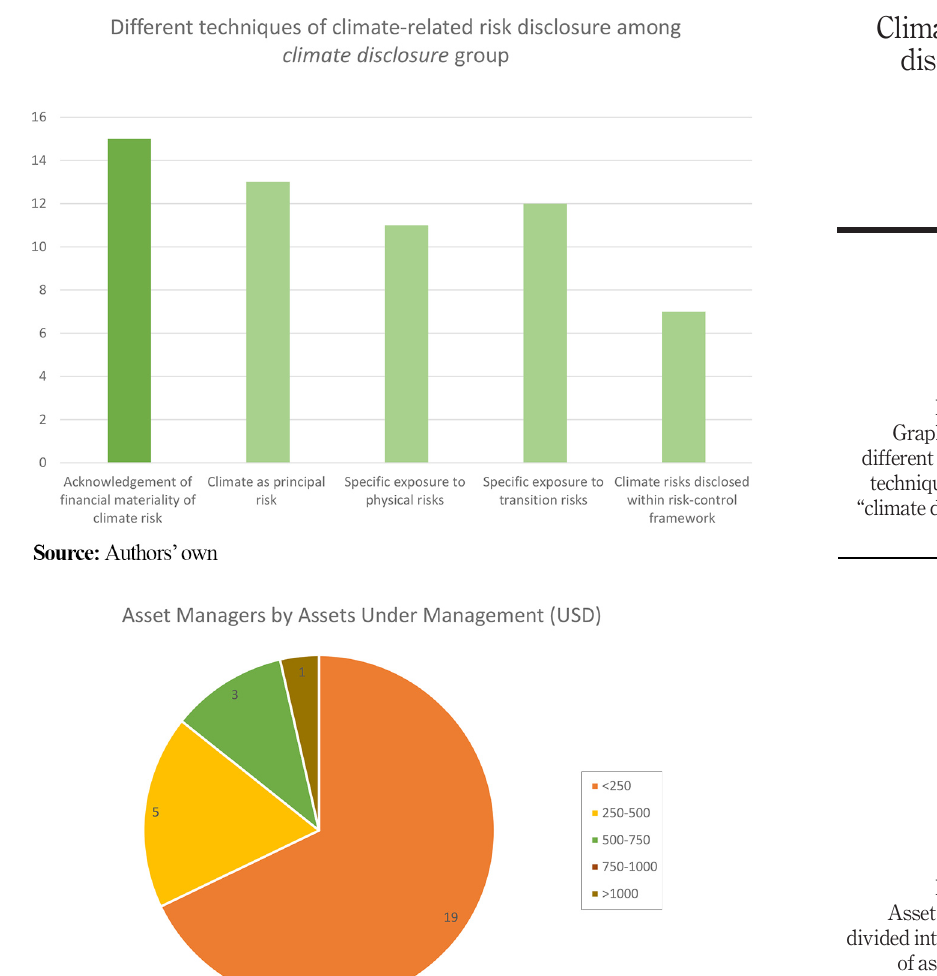
Figure 3. Asset managers divided into brackets of assets under management AUM